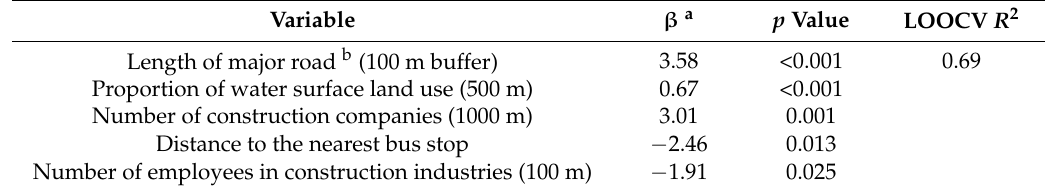
Table 1. Five selected geographic variables and cross-validated R 2 s from land use regression of PM 2.5 annual average concentrations during 2010 in Seoul, Korea.